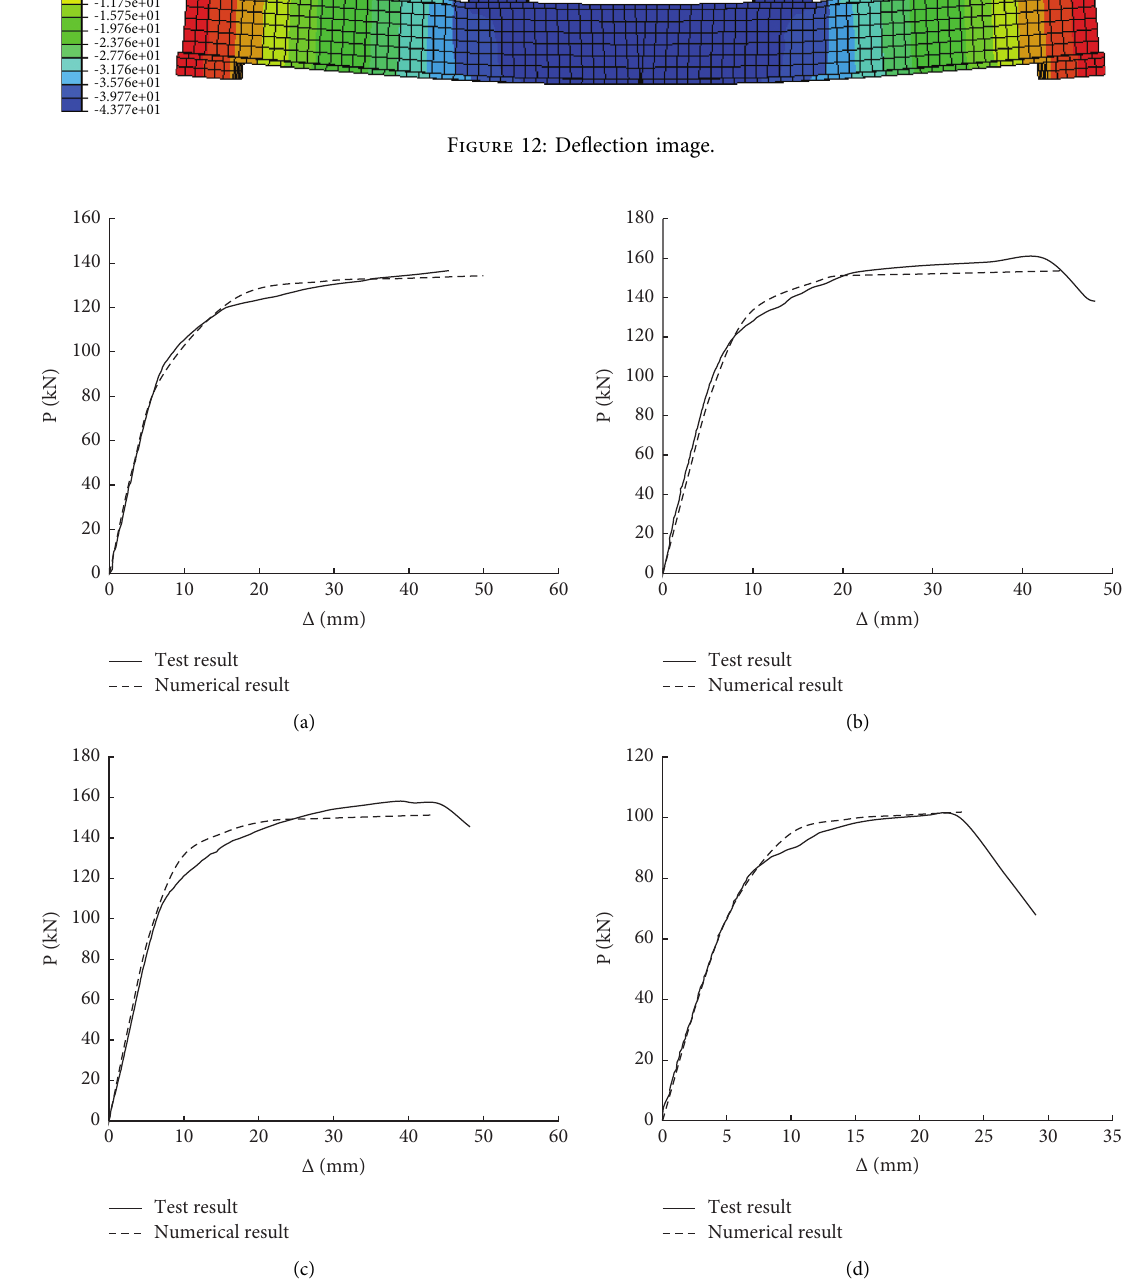
Figure 13: The comparison between numerical results and test results. (a) SB0. (b) CFSB1. (c) CFSB2. (d)